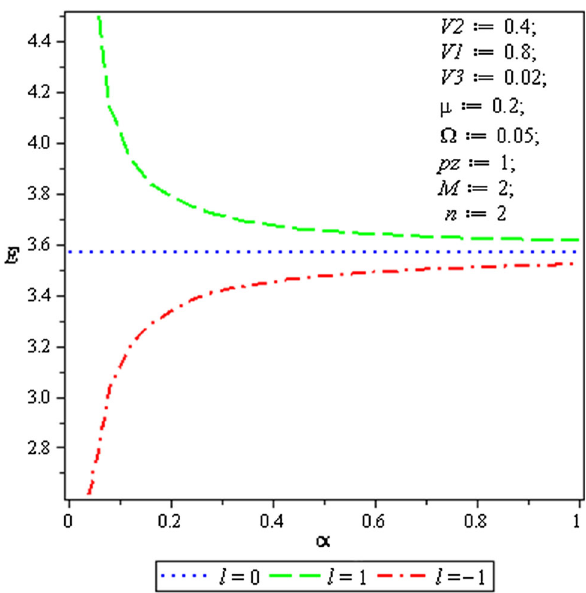
Fig. 2 Energy levels versus the parameter α with the different l